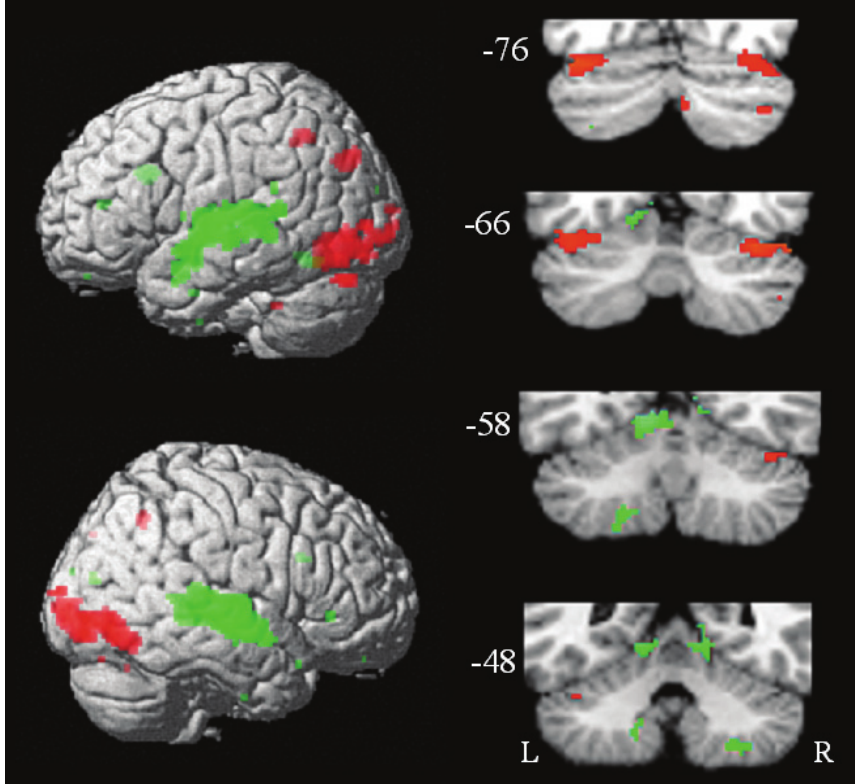
Fig.4. Differences inactivations patterns as afunction ofinput modality. Regions where the visual Load6 –Load 2condition showed significantly greater activation than the comparable auditory condition are displayed in the red color scheme and regions where the auditory condition showed significantly greater activation are shown in green. Activated voxels on the surface rendering were computed by a paired t-test between the modalities and thresholded at p < 0.005. Although the superior cerebellar activations were significant at this threshold, the inferior cerebellar activations (which a priori were hypothesized to show greater auditory response) are depicted here at a p < 0.025